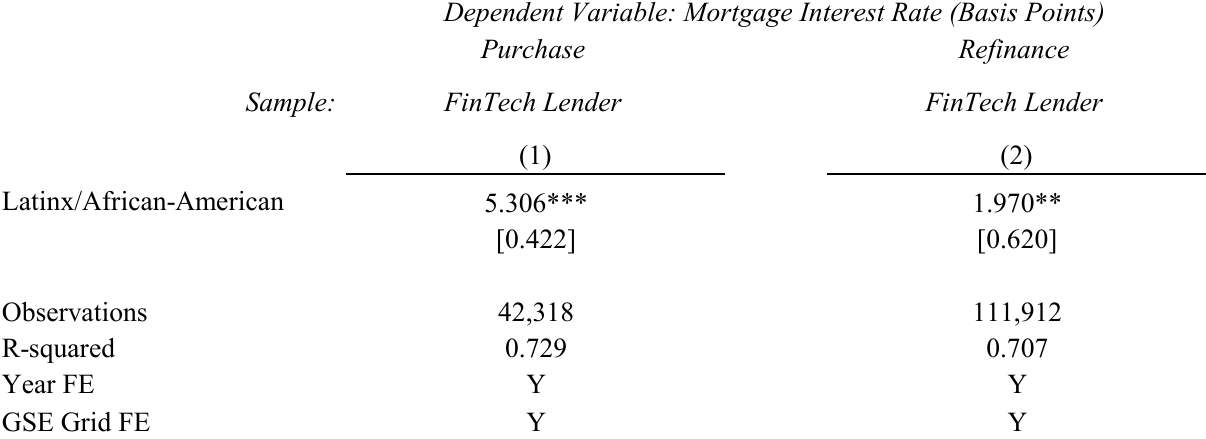
Table 3: Interest Rate Discrimination - FinTech Results table replicates our main credit risk specification, but only for the subsample of FinTech lenders. The columns reproduce the specification of column (2) and (4) of Table 2, regressing interest rates (in basis points) on the GSE grid dummy variables, month-year effects, and an indicator for whether the borrower is Latinx- or African-American. The sample is the list of FinTech platforms from Buchak et al (2017). Column (1) reports purchase-mortgage estimates, and column (2) reports refinance mortgages. Standard errors clustered at the lender level are in brackets. ***, **, and * indicate significance at the 1%, 5%, and 10% conventional